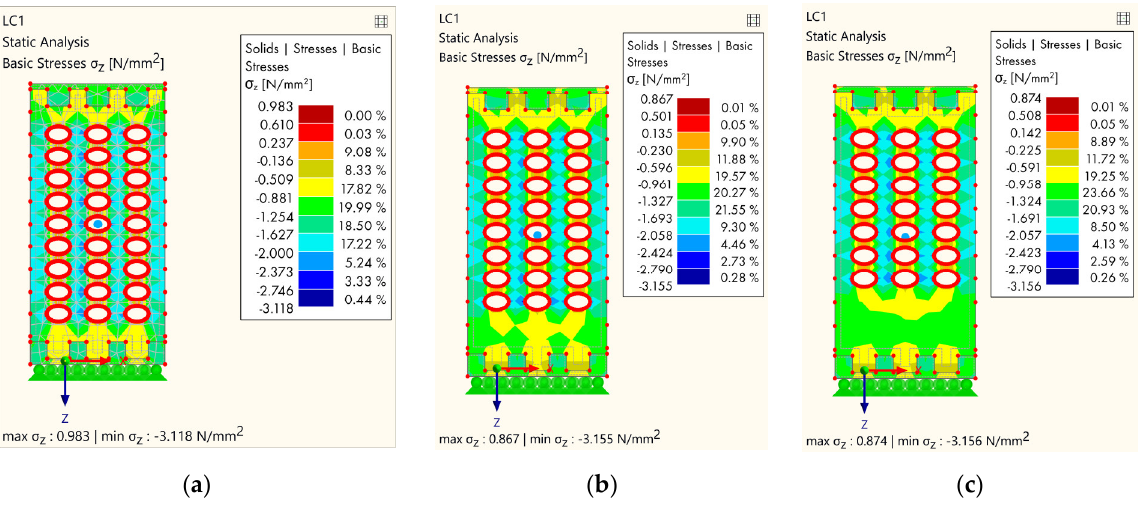
Figure 12. Results of FEM analysis—stress: ( a ) Completely perforated timber element; ( b ) the first lamella without cavities; ( c ) the second lamella without cavities.